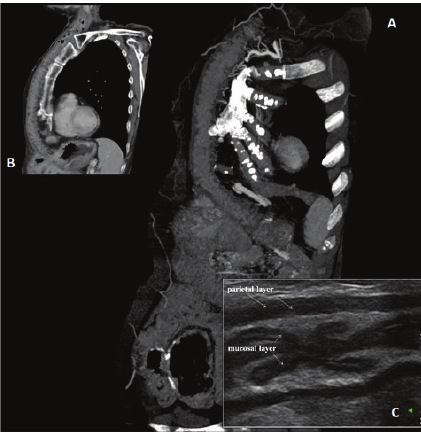
Figure 1: ((a)-(b)) Sagittal view CT images show the normal esophageal bypass position without signs of dilatation or ischemic su ff ering. (c) US image allows an optimal evaluation of mucosal and parietal layers in the whole length of the organ.